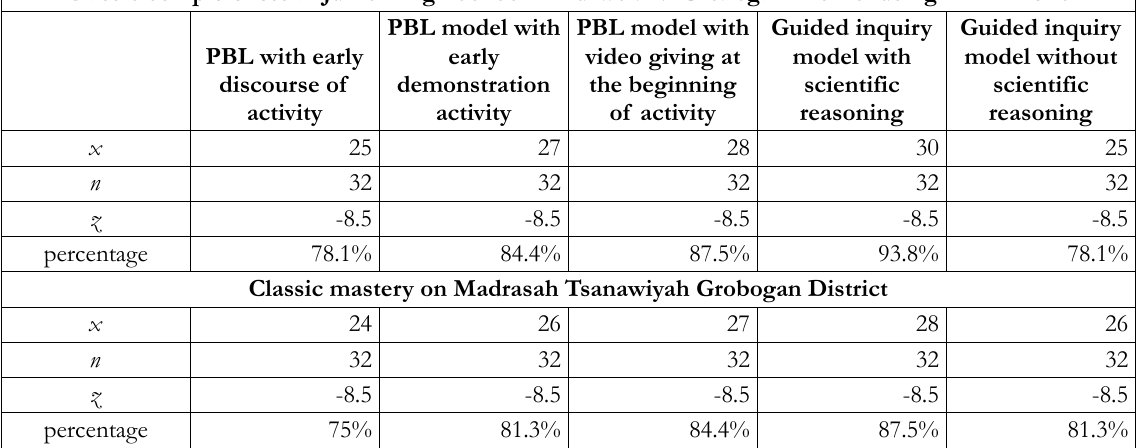
Table 3. Differences classical exhaustiveness test on each